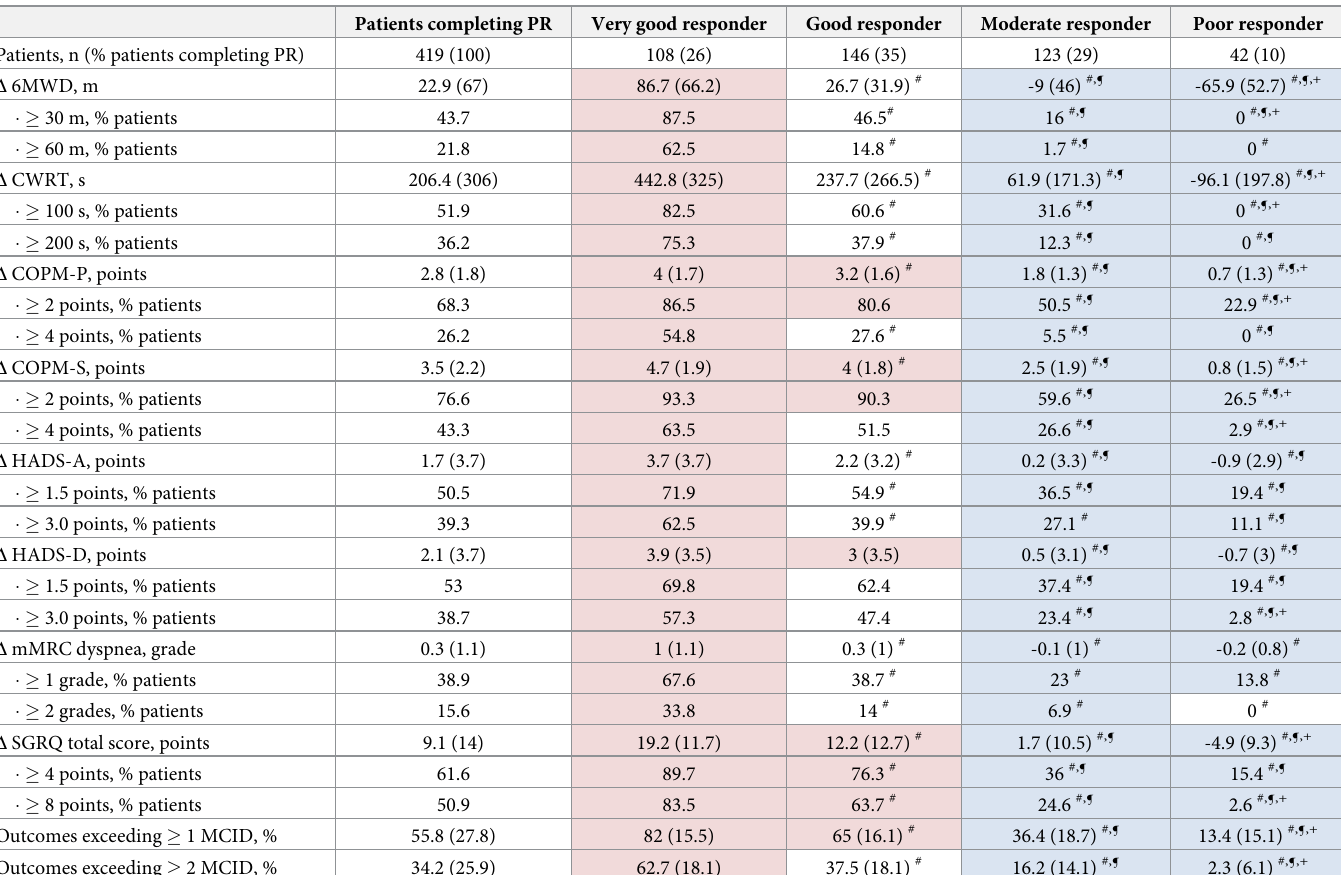
Table 2. Responses to pulmonary rehabilitation of all patients completing pulmonary